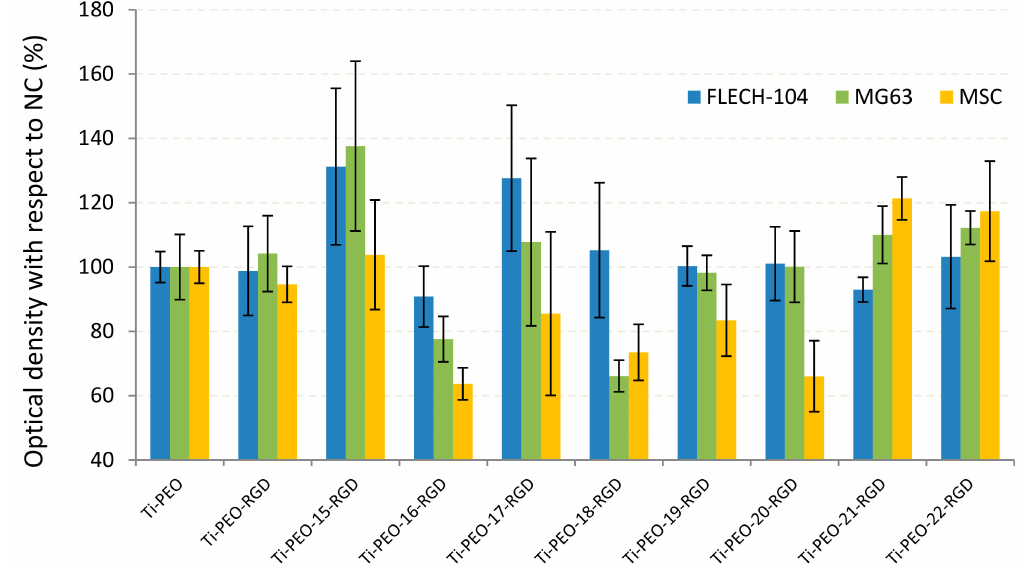
Figure 6. Optical density showing viability and proliferation of fibroblasts (FLECH-104), human osteoblast-like cells (MG-63) and mesenchymal stem cells (MSC) cultured on the surface of Ti-PEO functionalized by RGD-derivatives ( 15 – 22 ) after 7 days (metal samples were kept for 1 h at room temperature in the solutions of compounds 15 – 22 with concentrations 1.3 × 10 − 3 –1.8 × 10 − 3 M / L and then